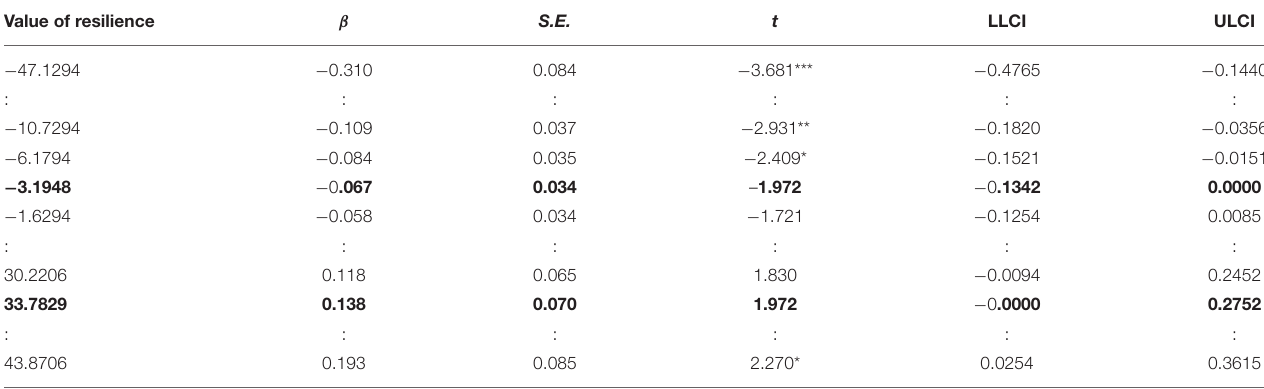
TABLE 5 | Significance area in the conditional effects of the focal predictor at values of the moderator (resilience). Value of resilience β S.E. t LLCI